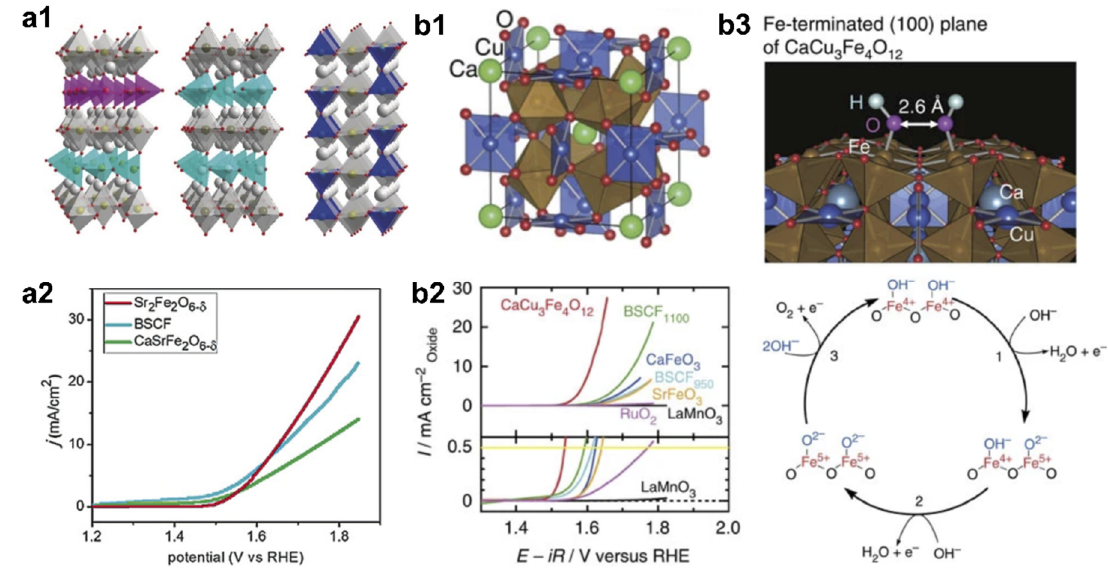
Figure 7. ( a ) Highly electronically-conductive Fe-based OER electrocatalysts: ( a1 ) The crystal structures (from left to right) of Ca 2 Fe 2 O 6–δ , CaSrFe 2 O 6–δ , and Sr 2 Fe 2 O 6–δ , and ( a2 ) the OER activity tested without a conductive carbon additive; reproduced with permission [81] Copyright (2019), John Wiley and Sons. ( b ) Covalency-reinforced Fe 4+ -based quadruple perovskite CaCu 3 Fe 4 O 12 OER electrocatalysts: ( b1 ) A structural illustration of CaCu 3 Fe 4 O 12 , ( b2 ) geometric OER activity, and ( b3 ) potential OER pathway on the surface of CaCu 3 Fe 4 O 12 ; reproduced with permission [11] Copyright (2015), Springer Nature.